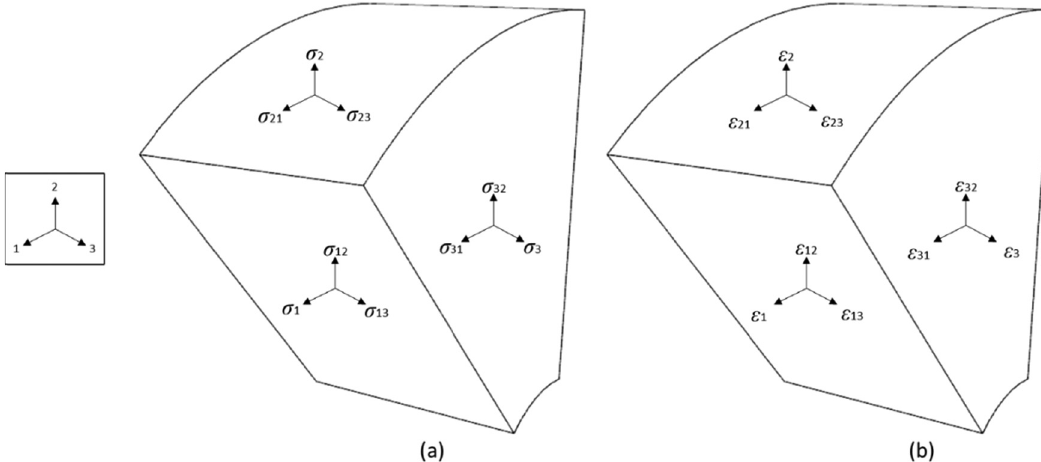
Figure 1: Element deformation: ( a ) stress and ( b ) plastic